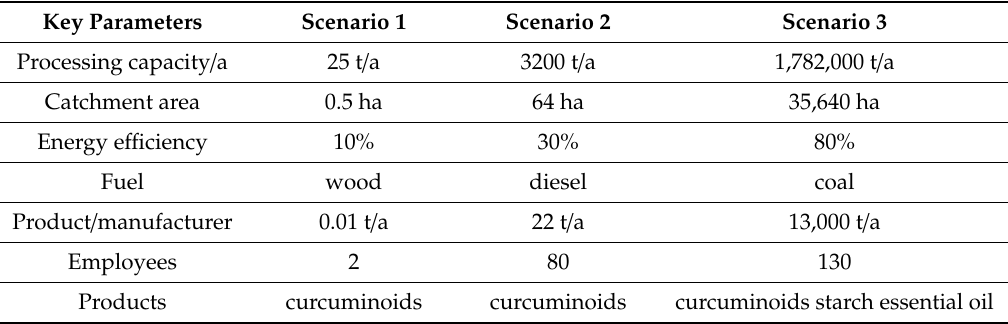
Table 4. Key parameters of the assessed production